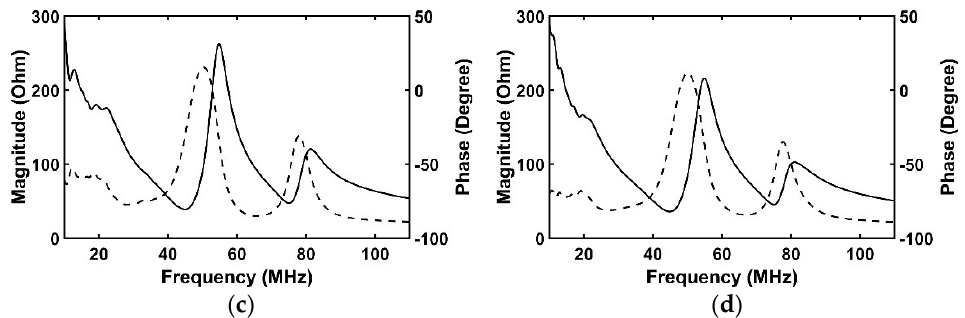
Figure 3. Simulated electrical impedance results of four transducers: ( a ) Ideal transducer #1; ( b ) conventional transducer; ( c ) ideal transducer #2; and ( d ) proposed transducer. The solid line and the dashed line indicate magnitude and phase respectively. Table 4. Simulated electrical impedance results.